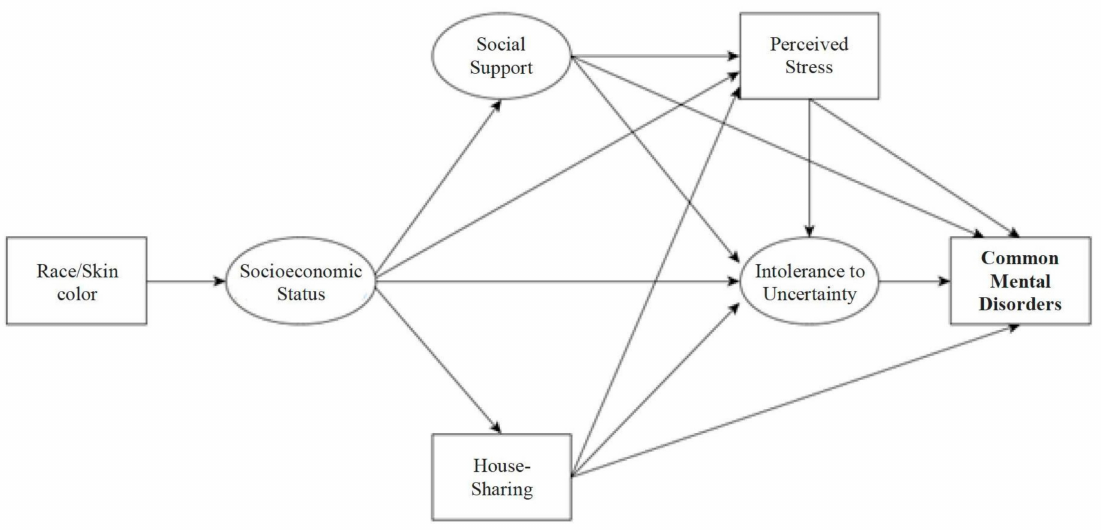
Figure 1. Conceptual structure of the determinants for the occurrence of CMDs in Brazilian men during the COVID-19